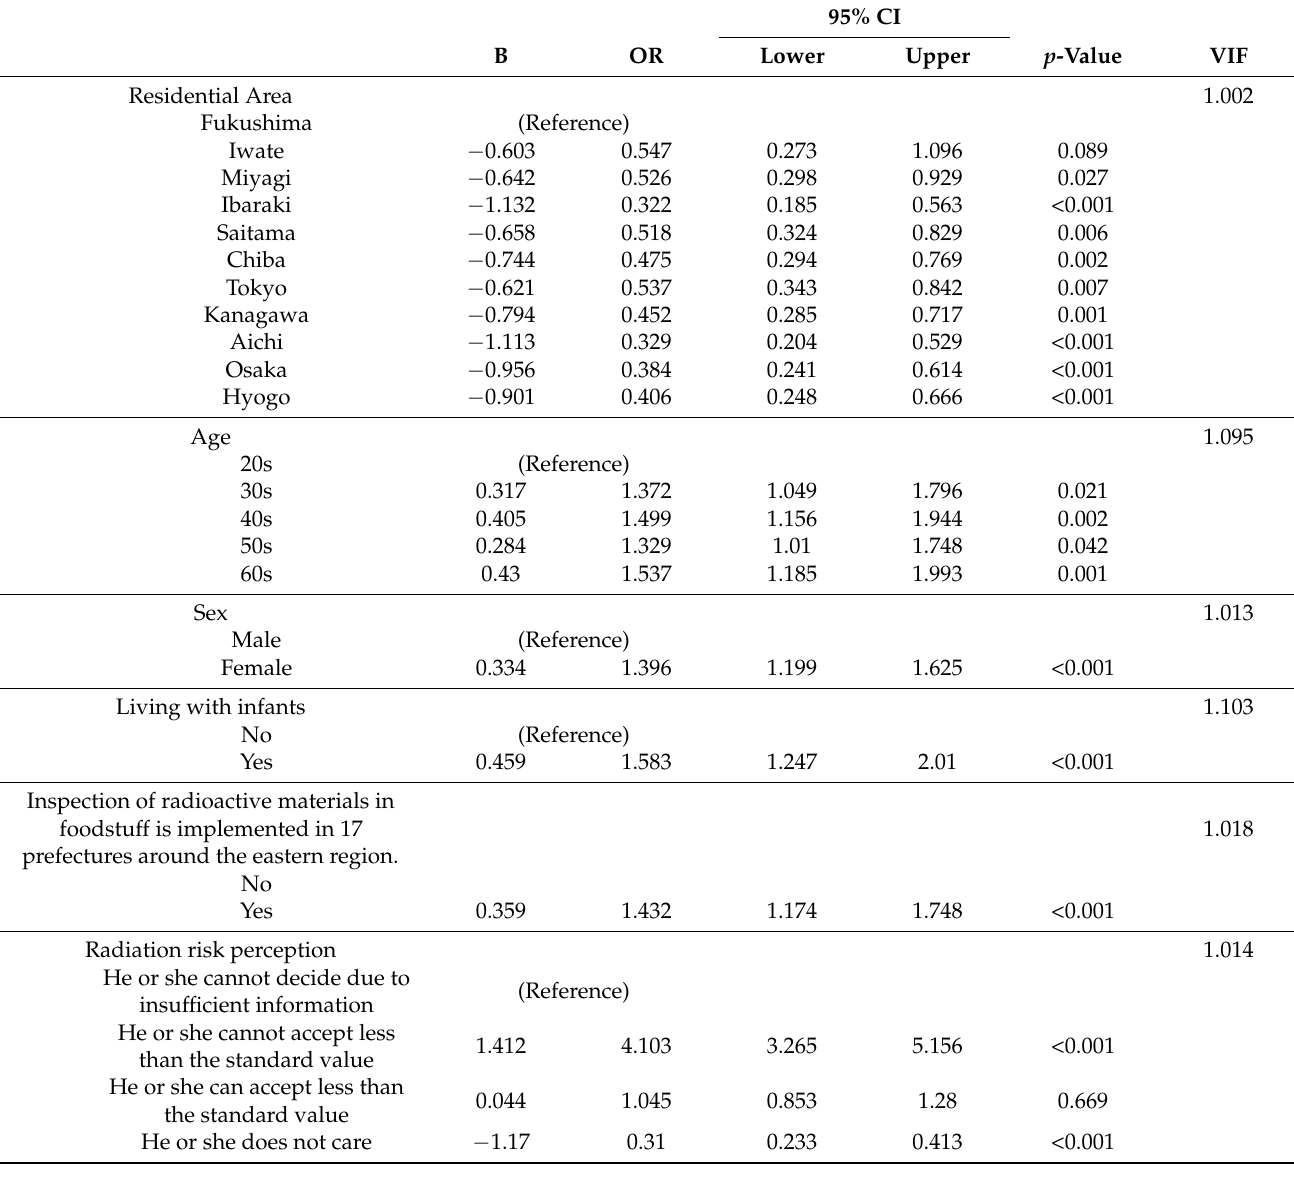
Table 2. Logistic regression analysis of refraining from purchasing foods produced in affected areas to avoid radioactive materials in the first